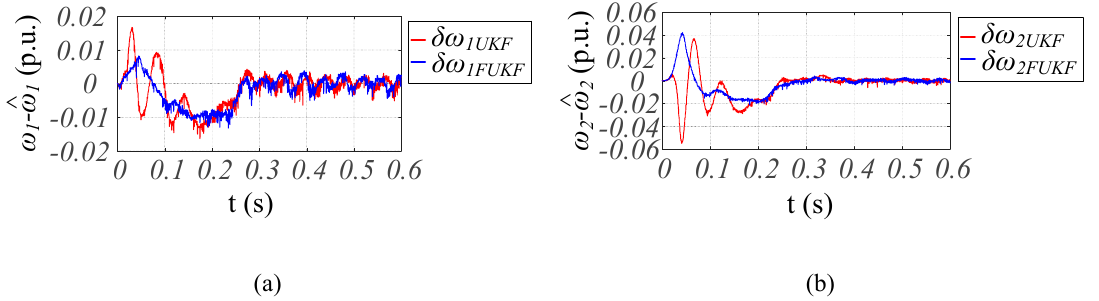
Table 5. Values of the percentage differences of the estimation errors and their derivatives for the FUKF in relation to the UKF – experimental study. Figure 7. Transients process of the adaptive control structure with the FUKF estimator – the Figure7. TransientsprocessoftheadaptivecontrolstructurewiththeFUKFestimator—theexperimental experimental results: the motor and load angular speeds (a), the electromagnetic, shaft and load results: the motor and load angular speeds ( a ), the electromagnetic, shaft and load torques ( b ), torques (b), the estimated value of the load time-constant of the machine (c), the load speed estimation the estimated value of the load time-constant of the machine ( c ), the load speed estimation error ( d ), error (d), the control structure coefficients (e, f) for the rated value of the reference speed signal. the control structure coe ffi cients ( e , f ) for the rated value of the reference speed signal.